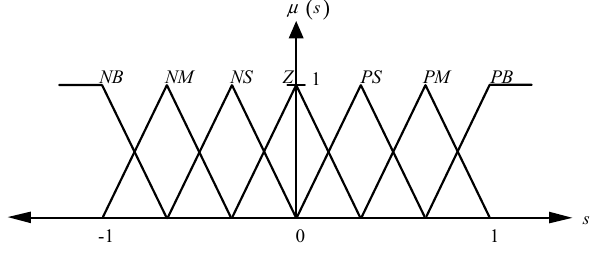
Figure 2. Membership function of input s